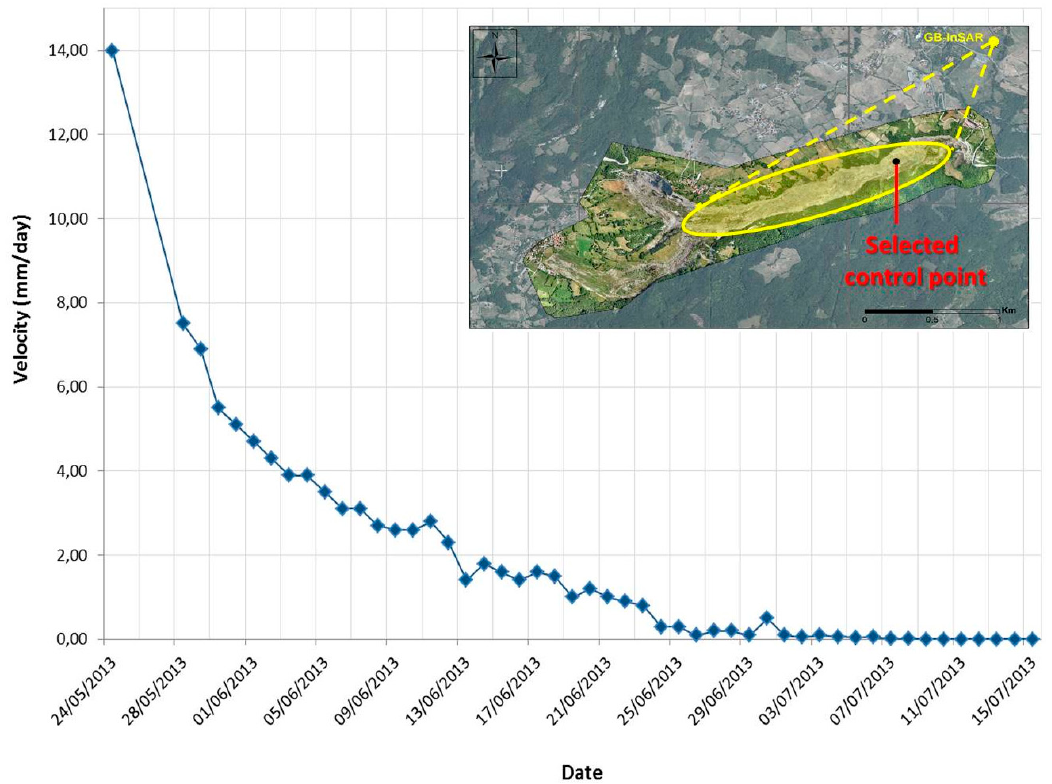
Figure 8. Time series of a control point selected in correspondence of the landslide toe, referring